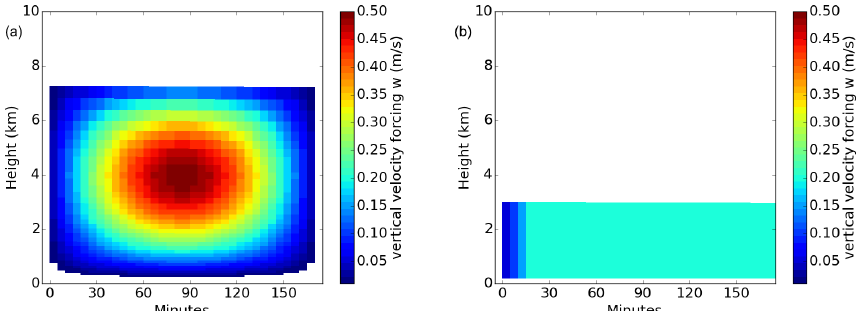
Figure 2. Time-height cross-section of the vertical velocity forcing used for the single-column (a) orographic lift case and (b) freezing drizzle case.